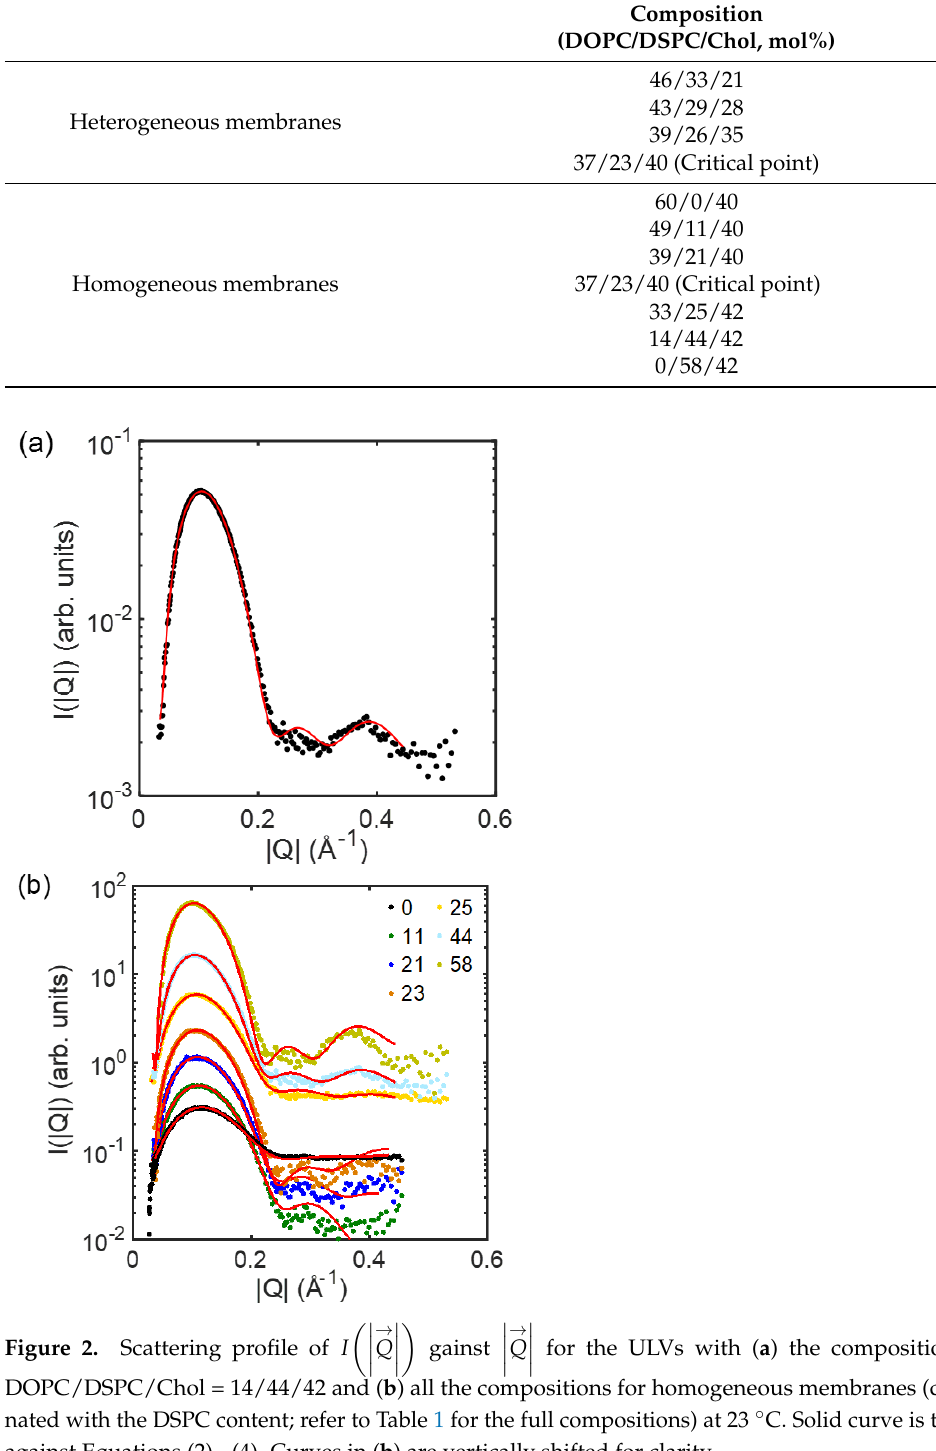
Figure 2. Scattering profile of 𝐼(|𝑄⃗ |) against |𝑄⃗ | for the ULVs with ( a ) the composition of DOPC/DSPC/Chol = 14/44/42 and ( b ) all the compositions for homogeneous membranes (desig- nated with the DSPC content; refer to Table 1 for the full compositions) at 23 °C. Solid curve is the fit against Equations (2)−(4). Curves in ( b ) are vertically shifted for clarity.